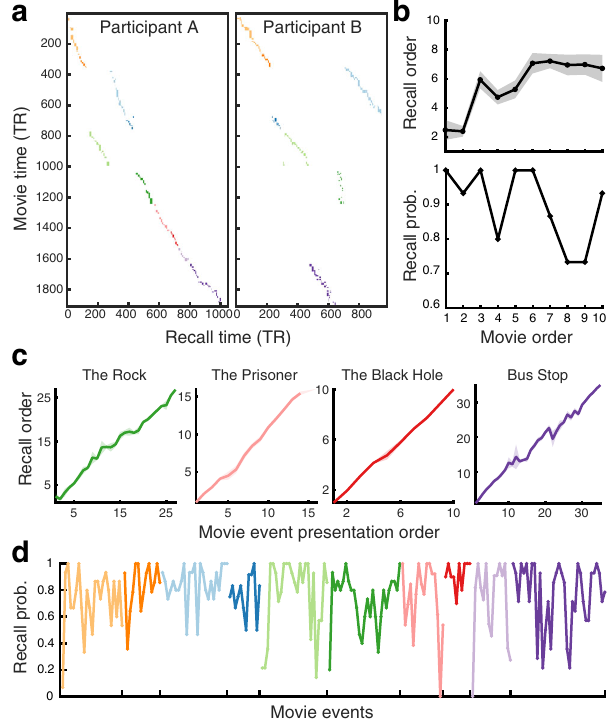
Fig. 2 Unguided spoken narrative recall behavior. a The duration and order of spoken recall for two example fMRI participants. Each colored rectangular dot represents a movie event. Different colors denote different movies. The x and y coordinates of a dot represent the temporal position of the event during recall and movie watching, respectively (TR = 1.5 s). The width and height of a dot represent the duration of the event during recall and movie watching, respectively. b Recall order (top) and recall probability (bottom) of the ten movies used in the fMRI experiment. c Recall order of individual movie events in four example movies. d Recall probability of individual movie events for the ten movies shown in different colors. In b and c , recall order was de fi ned as the rank among recalled movies or events (i.e., 1 = recalled fi rst, N = recalled last, where N is the total number of movies or events). Shaded areas indicate SEM across participants. In b and d , recall probability was calculated as the proportion of participants who recalled each movie or event. Source data for b – d are provided as a Source Data fi le.